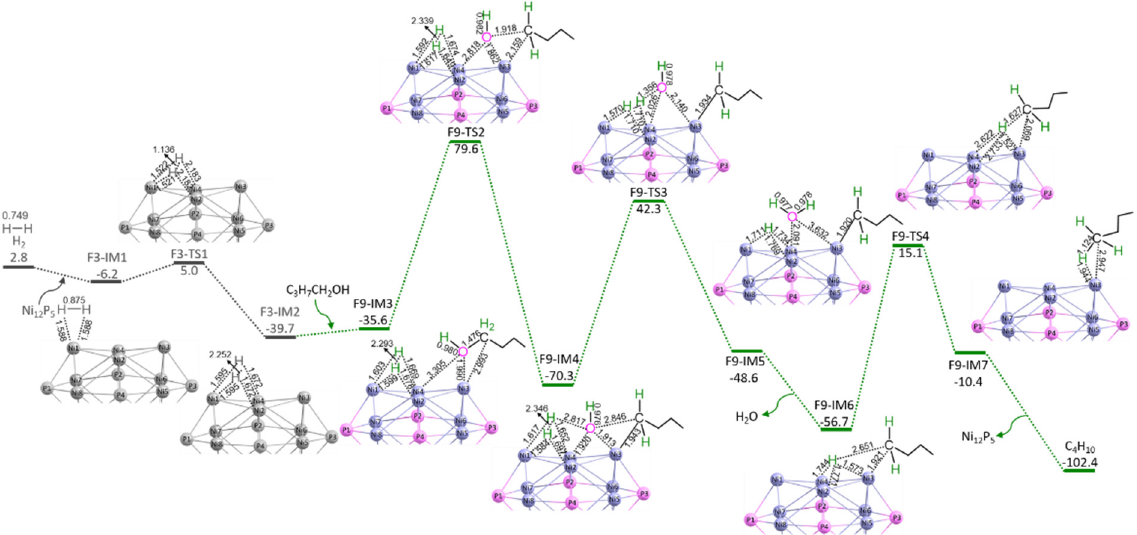
Figure 9. The potential energy curves with the relative Gibbs free energy ( G r , kJ mol − 1 ) and the geometric structures with bond lengths (Å) reaction stage S9 over Ni 12 P 5 cluster at GGA − PBE/DSPP, DNP level. For brevity, some hydrogen atoms are hidden.